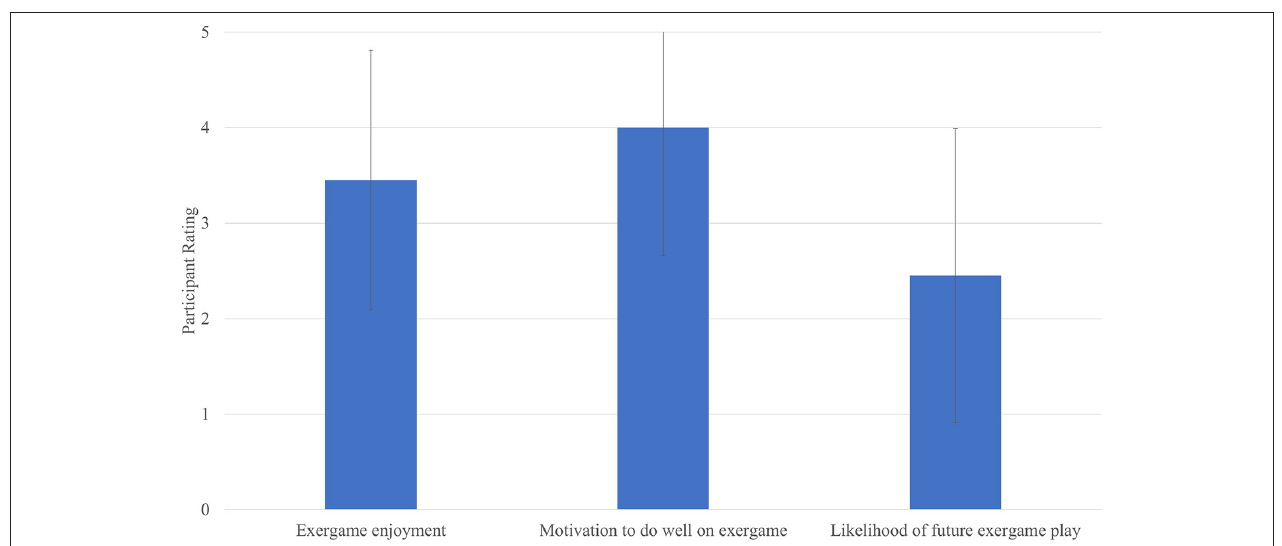
FIGURE 1 | Participants’ quantitative feedback on exergames ( N = 20). Higher scores indicate more favorable responses. Bars indicate mean rating and lines indicate standard deviations for each item.